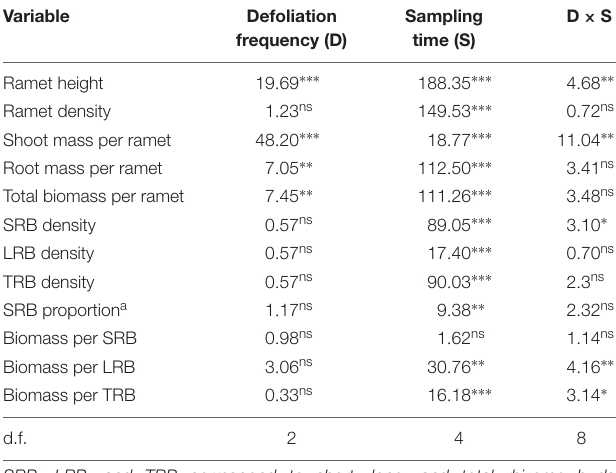
TABLE 1 | Summary of repeated ANOVAs on plant traits in Carex brevicuspis populations for three defoliation frequencies